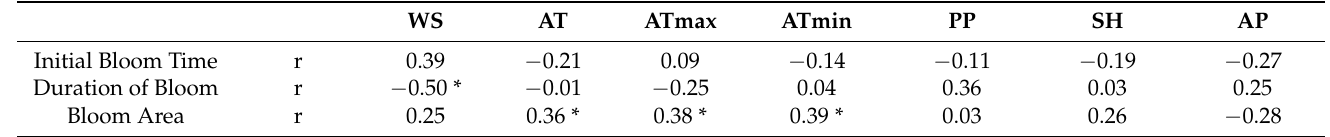
Table 2. Relationship between the initial bloom date, bloom duration, and bloom area in Lake Dianchi and climate